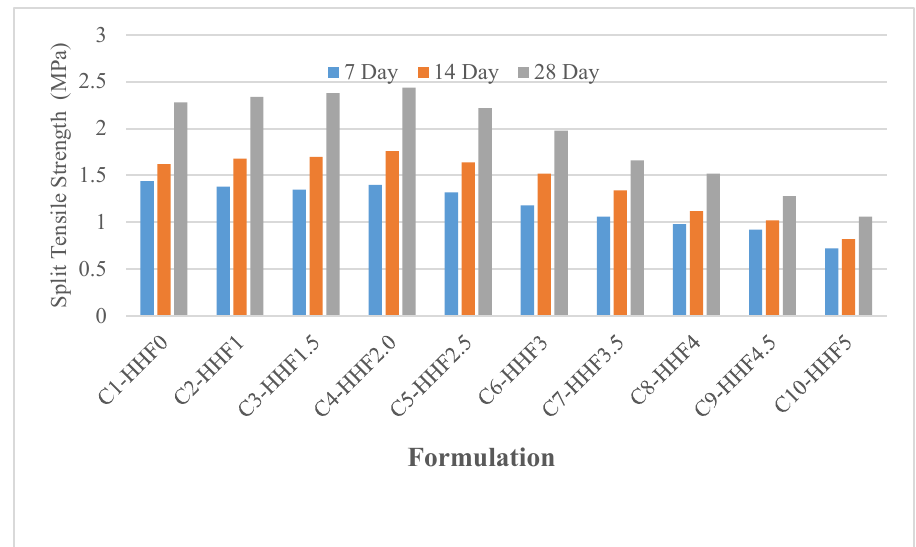
Figure 7. Split tensile strength of concrete human hair fiber.